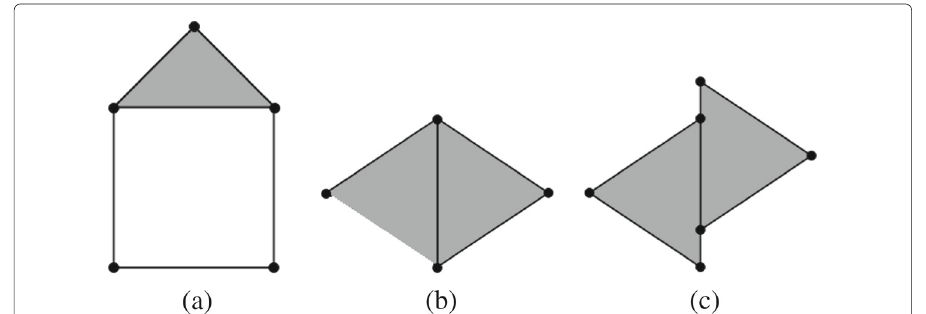
Fig. 2 Finite collection of simplices where ( a ) is a simplicial complex and, ( b ) and ( c ) are not since there is a missing edge in ( b ) and two triangles meet along an edge which is not an edge of either triangle in ( c )